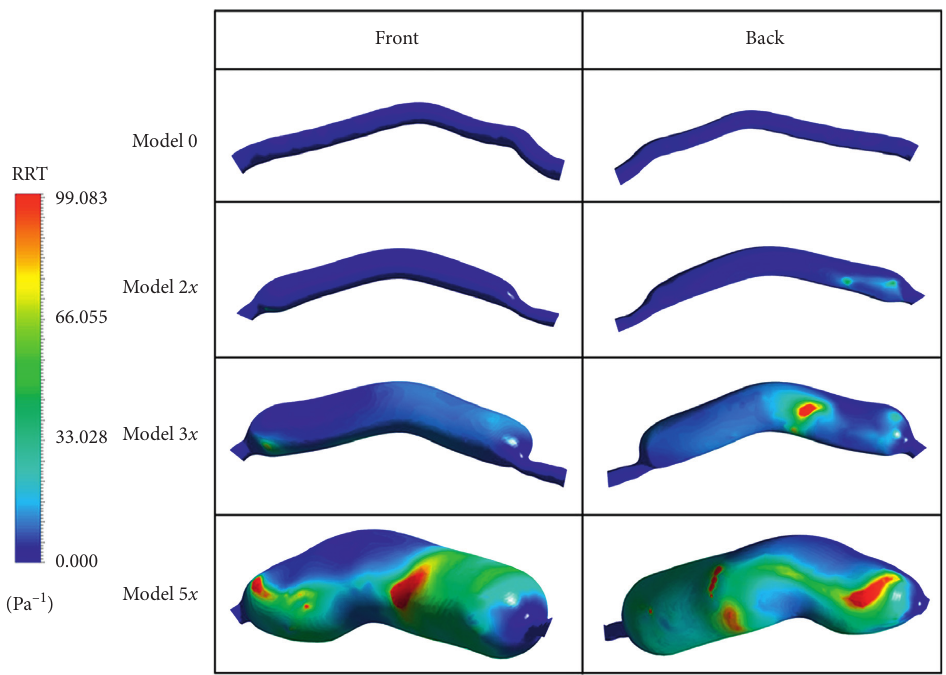
Figure 8: Relative residence time (RRT) distribution in the coronary artery aneurysm for the four